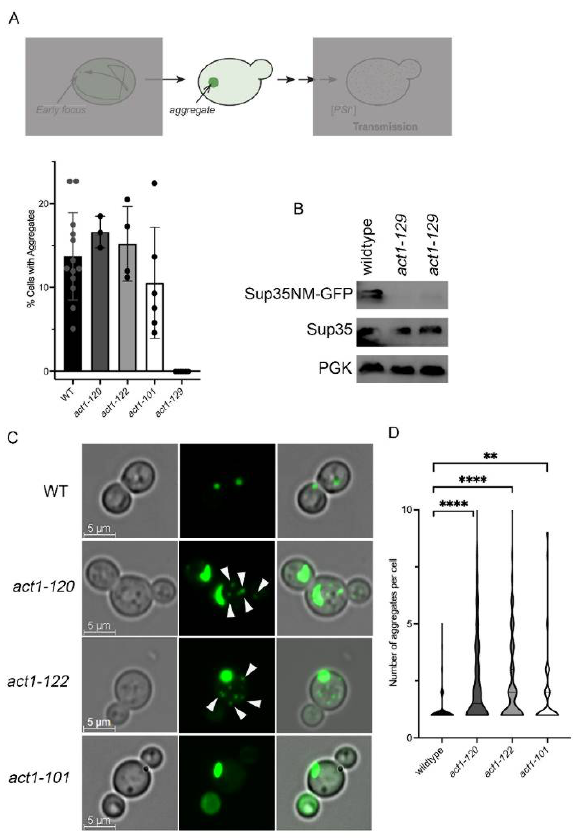
Figure 1. Multiple Sup35NM-GFP aggregates are detected in act1-120 and act1-122 strains. ( A ) Top, model showing multiple steps of [ PSI + ] formation analyzed in this paper and highlighting the aggregate step as the primary focus of this figure. Bottom, BY4741 strains containing Sup35NM-GFP were grown in the presence of copper for 48 h to assess the formation of aggregates. Each dot represents at least 50 cells from an individual transformant (six transformants were screened for act1-129 ). Data are shown as means ± SD. Note that act1-129 strains showed low visible GFP signal. ( B ) Western blot analysis of two independent act1-129 transformants expressing Sup35NM-GFP for 24 h. Anti-GFP (top), anti-Sup35C (to detect endogenous Sup35), and anti-PGK antibodies were used. ( C ) Bright field, GFP, and merged images of the indicated strains are shown. Arrows indicate the small visible aggregates formed in act1-122 and act1-120 strains. ( D ) The number of aggregates per cell was assessed in the indicated strains. Data shown as a violin plot to indicate the number of aggregates per cell observed. Each plot represents a total of 66–248 cells from at least three independent experiments. ** p < 0.001 and **** p < 0.0001 values by Welch’s t -test.